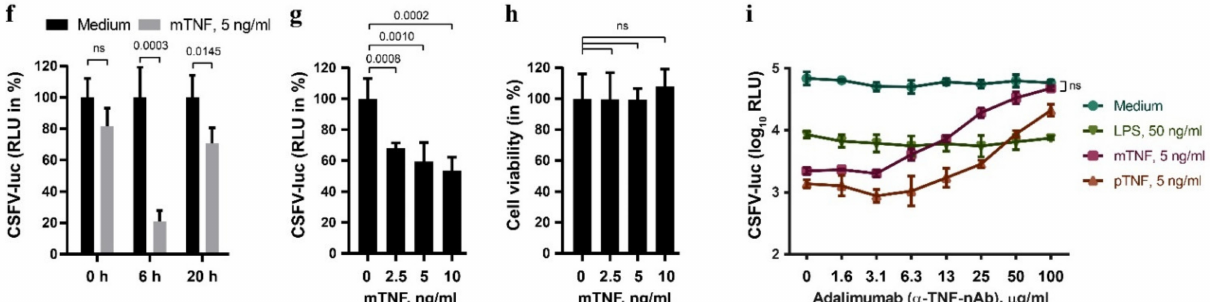
Figure 1. TNF antagonizes CSFV infection in porcine aortic endothelial cells and in primary porcine MDM, but not in PK-15 and SK-6 cells. ( a ) The PEDSV.15, PK-15 and SK-6 cells were treated with mTNF (5 ng/mL) or the medium for